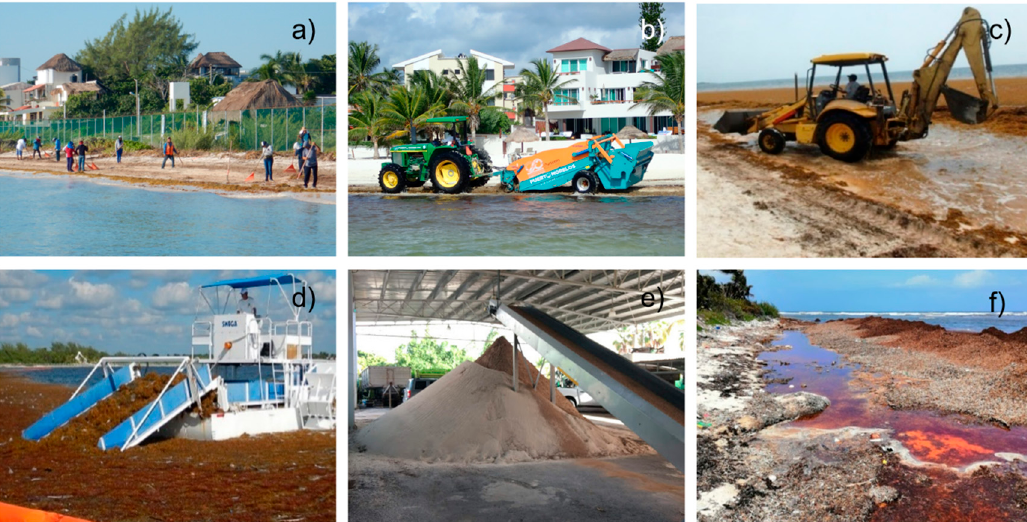
Figure 10. Removing beached sargasso from the Mexican Caribbean: ( a – c ) on the beach, and ( d ) in coastal waters. ( e ) Sand recovery in one of the hotels (huge amounts of sand are removed during sargasso clean-up activities on the beaches). ( f ) When large amounts of sargasso are left on the beach pools of leachates can be produced.